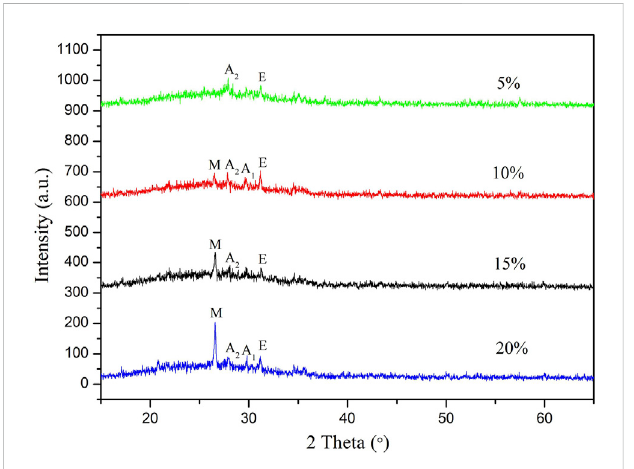
FIGURE 3 XRD patterns of glaze surface of samples with different QS contents: (M-Mullite, A 1 -Augite, A 2 -Anorthite,